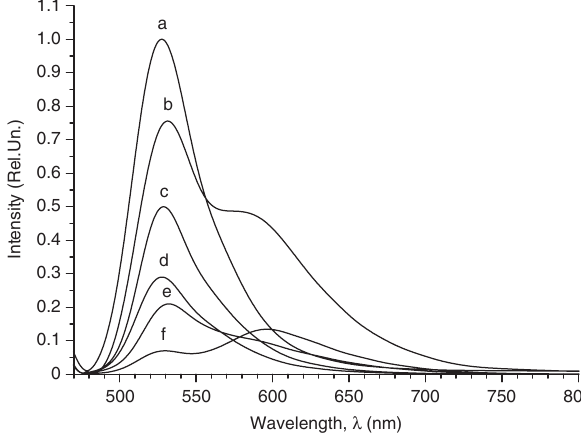
Figure 18 Influence of Cu(I) ([ascorbic acid]/[Cu 2+ ] 2:1) and laser irradiation ( λ = 457 nm) on electron excitation energy transfer effectiveness from AO to EB intercalated in DNA. (a) DNA-AO; (b) DNA-AO-EB; (c) DNA-AO-Cu(I); (d) DNA-AO-Cu(I) 10-min irradiation; (e) DNA-AO-Cu(I)-EB; (f) DNA-AO-Cu(II) 10-min irradiation+EB. [DNA]